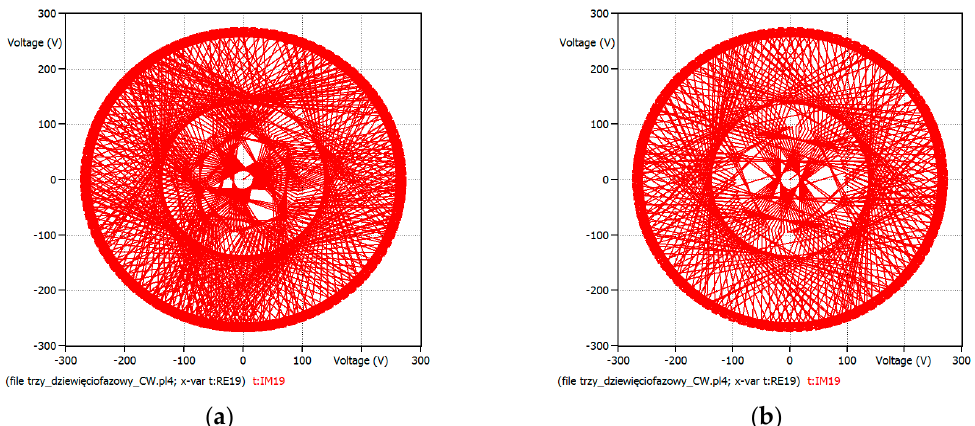
Figure 12. Trajectory of the output voltage rotating space vector for output frequency: ( a ) 30 Hz; ( b ) 50 Hz. Simulations performed for the voltage transfer ratio k U = 0.5, for one period of output frequency and CW method.